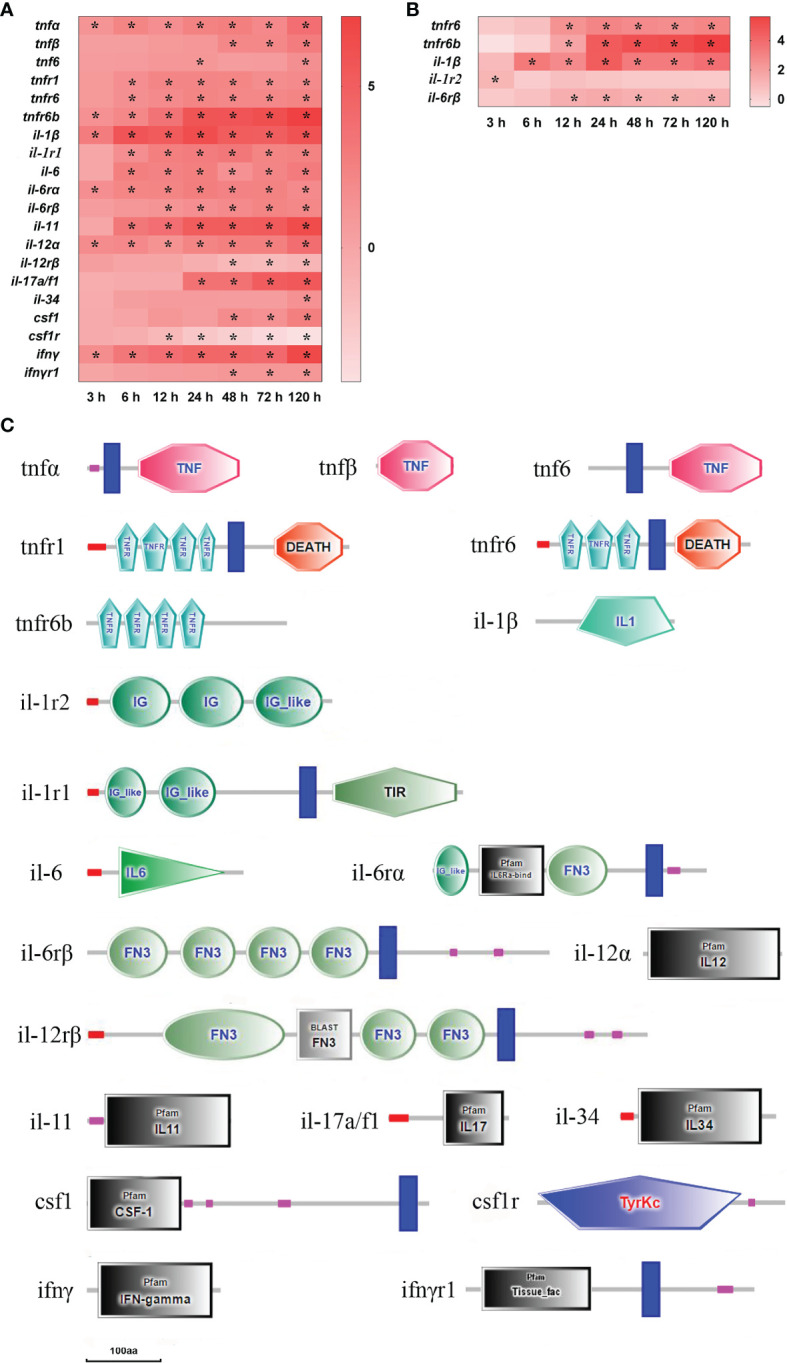
The DEGs of inflammatory cytokine in yellow catfish after E. ictaluri infection. (A, B): The DEGs identified in the spleen and liver, respectively. The DEGs of inflammatory cytokine were analyzed at 3 h, 6 h, 12 h, 24 h, 48 h, 72 h and 120 h post-infection in the spleen and liver. The color gradient represents highly up-regulated (red) to highly down-regulated (white) genes. Significant differences at different time points post-infection compared to the control (0 h) are indicated by asterisks (*P < 0.05). (C): Structural features of inflammatory cytokine DEGs in yellow catfish. The domain organizations were predicted by the SMART online server.